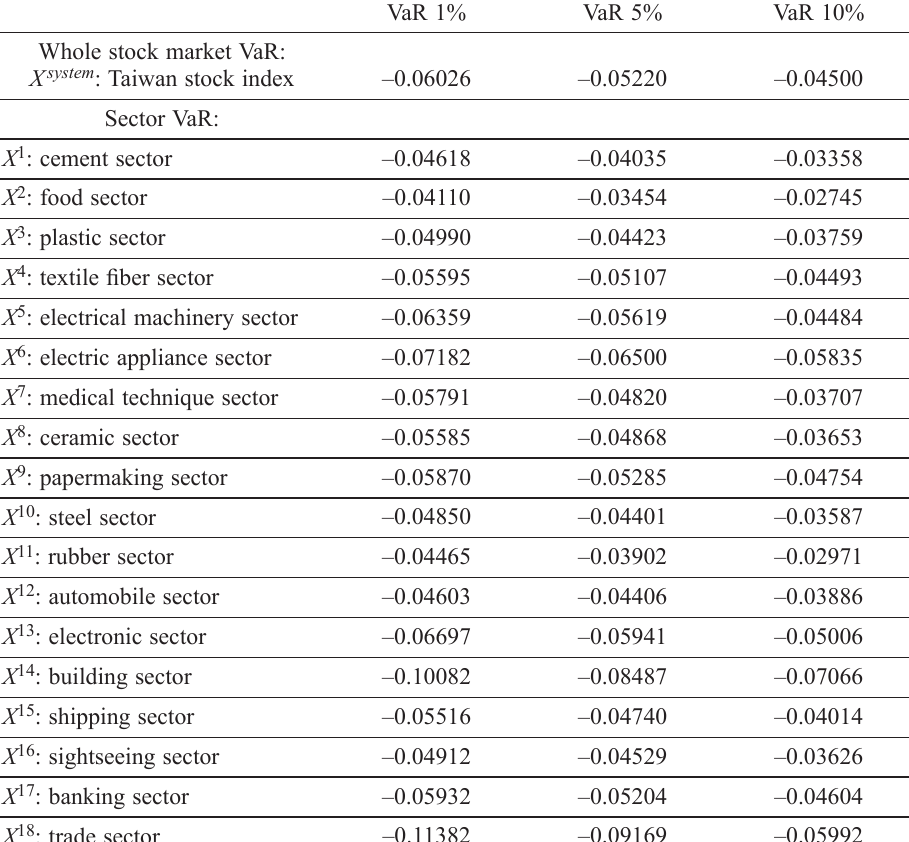
Table 2. VaR of stock index & sector index at 1%, 5% and 10% respectively VaR 1% VaR 5% VaR